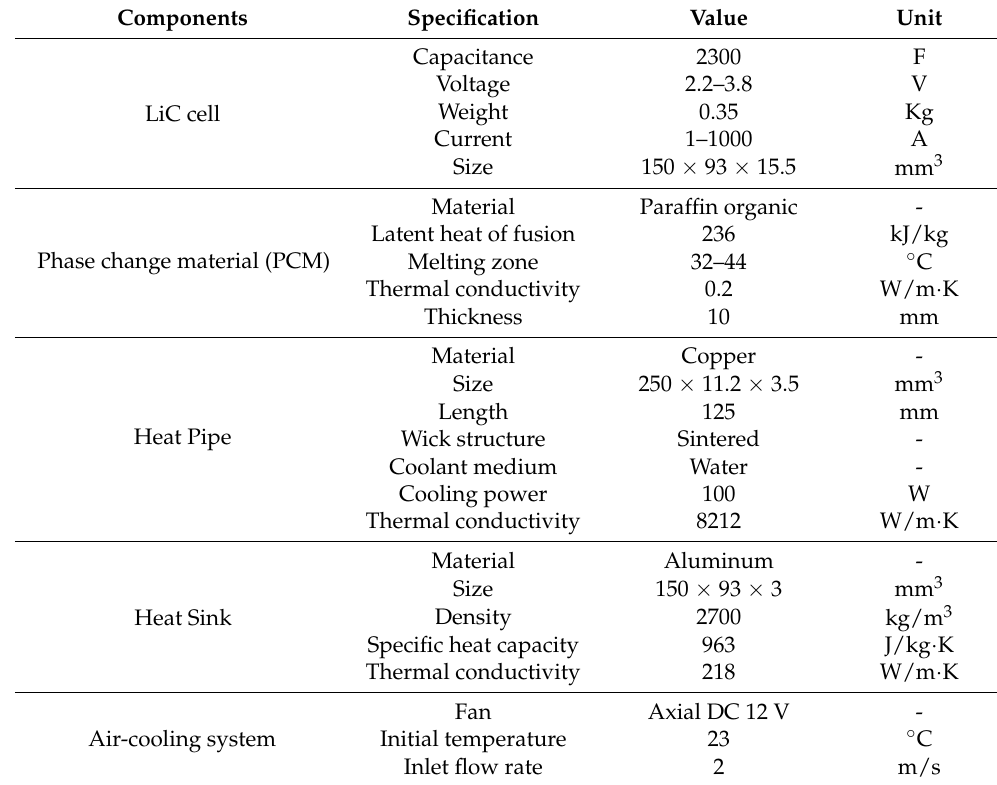
Table 1. Specifications of the test bench